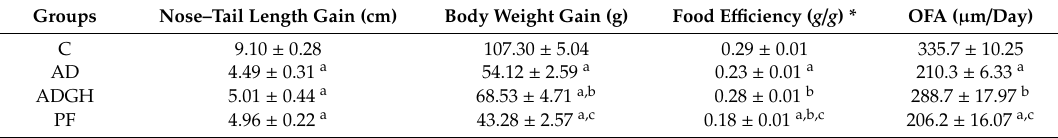
Table 2. Growth parameters in the groups of rats ( n ≥ 5 per group).